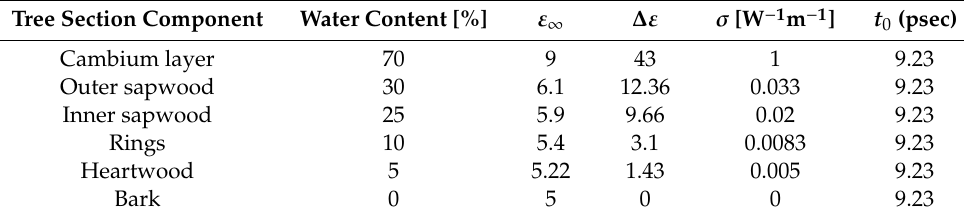
Table 1. The extended Debye properties of the tree layers [58].